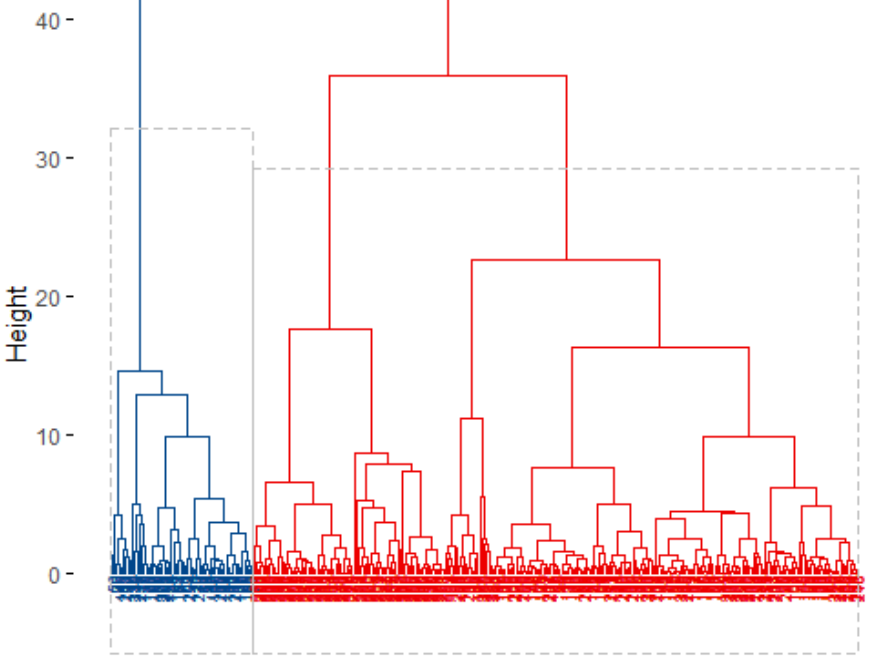
Figure 2. Dendrogram of the bottom-up agglomerative clustering. Each leaf corresponds to one student. Students that are similar to each other are combined into branches, which are themselves fused at a higher height. The height of the fusion, provided on the vertical axis, indicates the (dis)similarity/distance between two profiles/clusters. The hierarchical tree was cut in order to partition the data into clusters (blue for Cluster 1 = 265 and red for Cluster 2 = 62). Table 3. Characteristics of the undergraduate students by identified